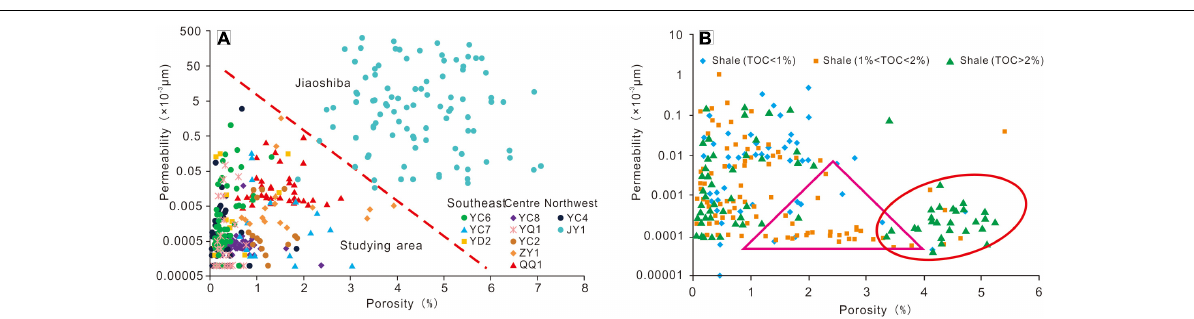
between 5 × 10 − 7 and 16.26 × 10 − 3 µ m 2 , while the permeability of 72.1% of the region is 1 × 10 − 4 to 1 × 10 − 5 µ m 2